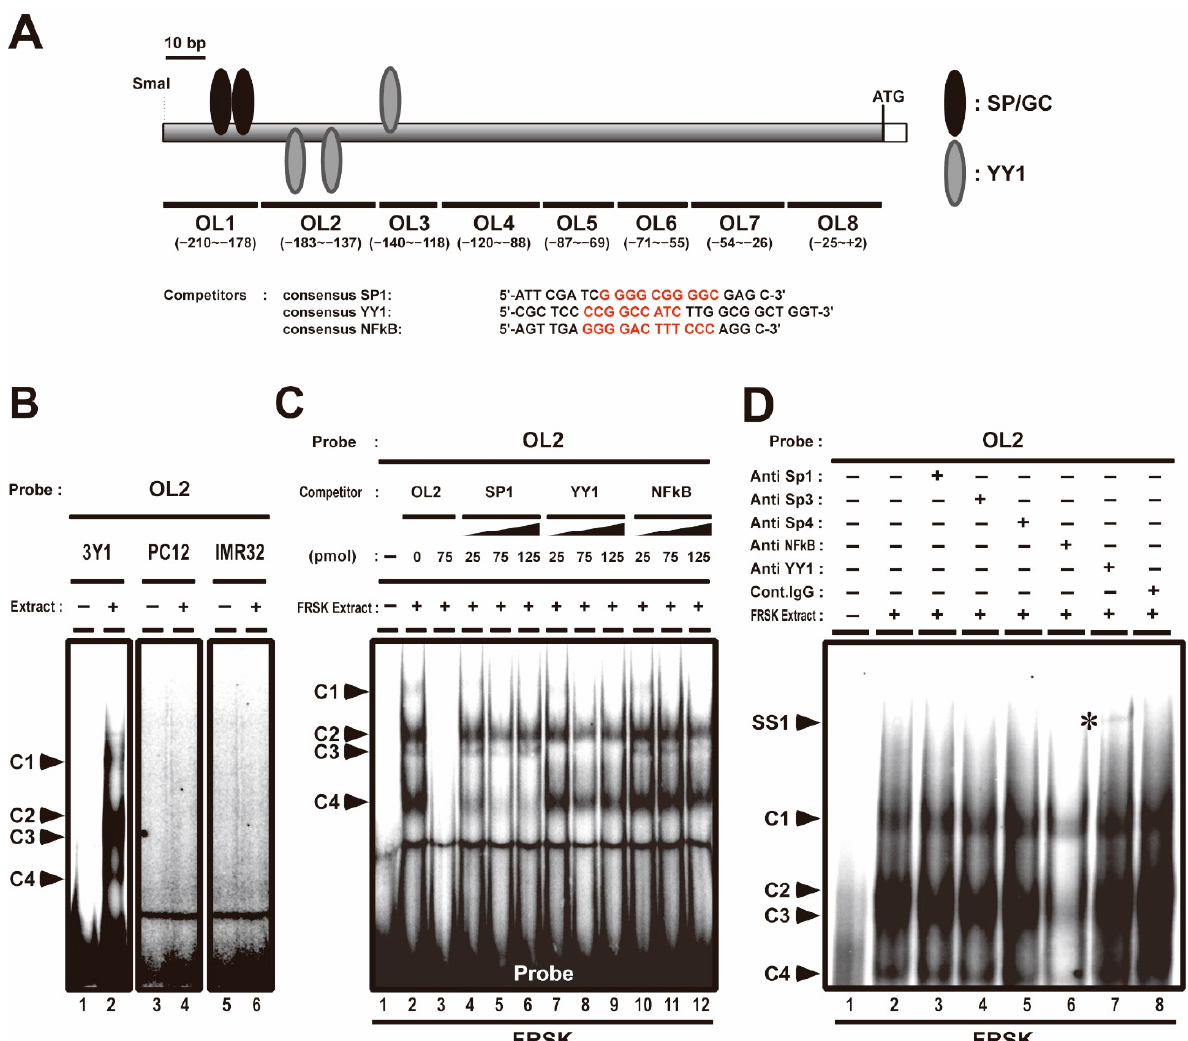
Figure 1. Competitive electrophoresis mobility shift assays (EMSA) and supershift assays with OL2 ( − 183 to − 137) region in the core-promoter region (CPR) of Stx1a . ( A ): Scheme of OL2 probe and competitors (consensus OL) used with competitive electrophoresis mobility shift assays (EMSA). The consensus sequences of SP, YY1 and NF κ B are indicated in red. ( B ): EMSA with OL2 for binding to nuclear extract of 3Y1 fibroblast cells, PC12 adrenal pheochromocytoma cells and IMR32 neuroblast cells. Arrowheads indicate shift-bands by DNA–protein complexes (C1, C2, C3 and C4). ( C ): Competitive EMSA with OL2 for binding to nuclear extract of fetal rat skin keratinocyte (FRSK) cells. Arrowheads indicate shift-bands by DNA–protein complexes (C1, C2, C3 and C4). ( D ): Supershift assay of the OL2–protein complex in FRSK cells. Nuclear extract from FRSK cells was incubated with antibodies for Sp1, Sp3, Sp4, NF κ B and YY1 before the addition of the OL2 probe. Arrowheads indicate the shift-band by DNA–protein and DNA–protein–antibody complex. The supershift bands (SS1) by DNA–protein–antibody complex are indicated with asterisks.